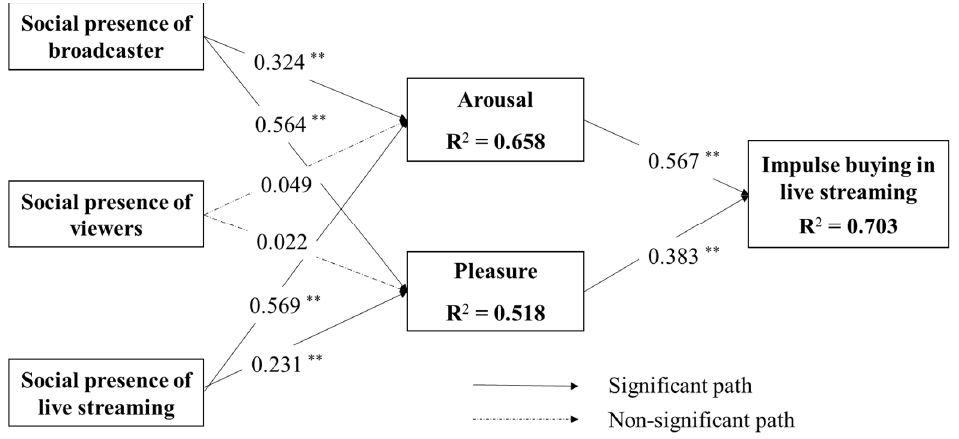
Figure 3. Results of the structure mode. Note: ** p < 0.01